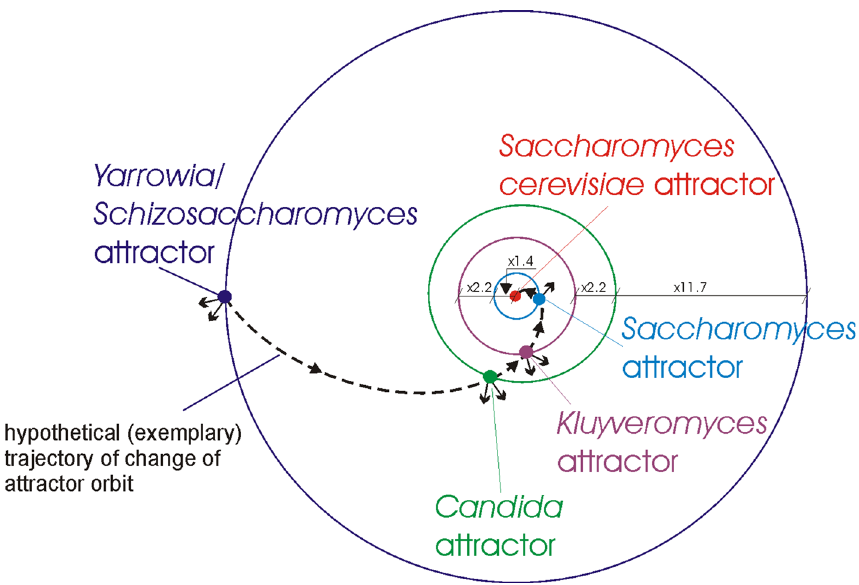
Figure 4. Orbits and genome attractors during yeast evolution. Yarrowia / Schizosaccharomyces attractor orbit is disturbed most strongly by the attraction in the Poplar mushroom {#8} (with average similarity to all organisms in the attractor equals to 0.006) and Green alga {#2} (0.004) directions—schematically presented by small arrows from the attractor. Candida attractor orbit is disturbed most strongly by the attraction in the Poplar mushroom {#8} (0.008) and Green alga {#2} (0.002) directions. Kluyveromyces attractor orbit is disturbed most strongly by the attraction in the Poplar mushroom {#8} (0.004) and Green alga {#2} (0.002) directions. Saccharomyces attractor orbit is disturbed by the attraction in the Poplar mushroom {#8} (0.001)